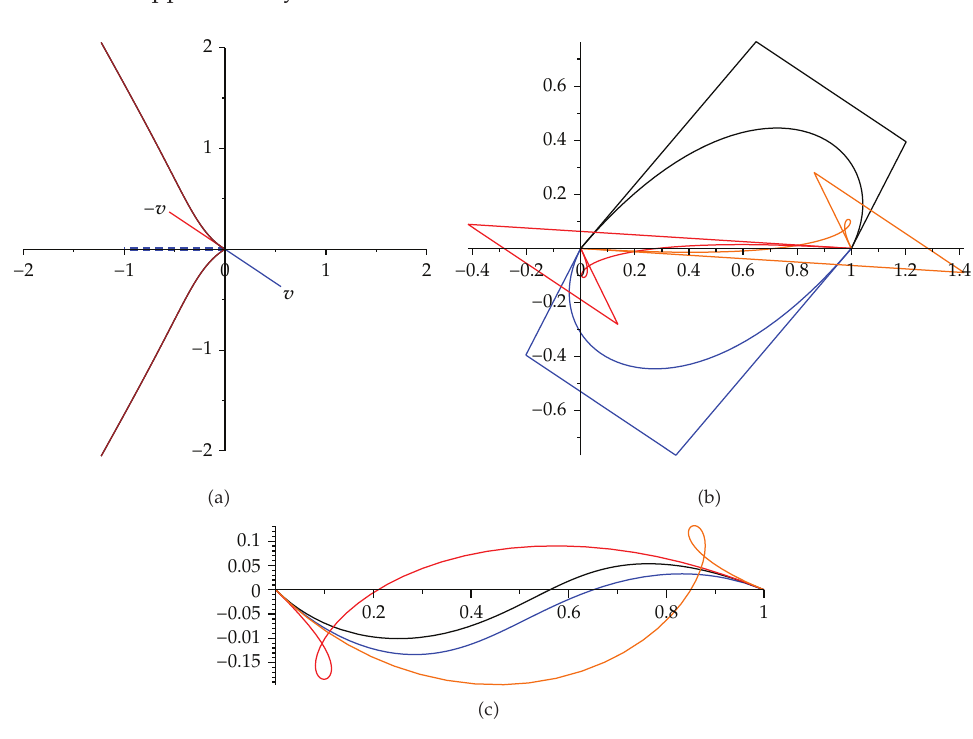
−√ −√ − 1 π/ 4 , 2 e − 1 π/ 8 (cid:3) , the graph on the left shows that − v ∈ D and